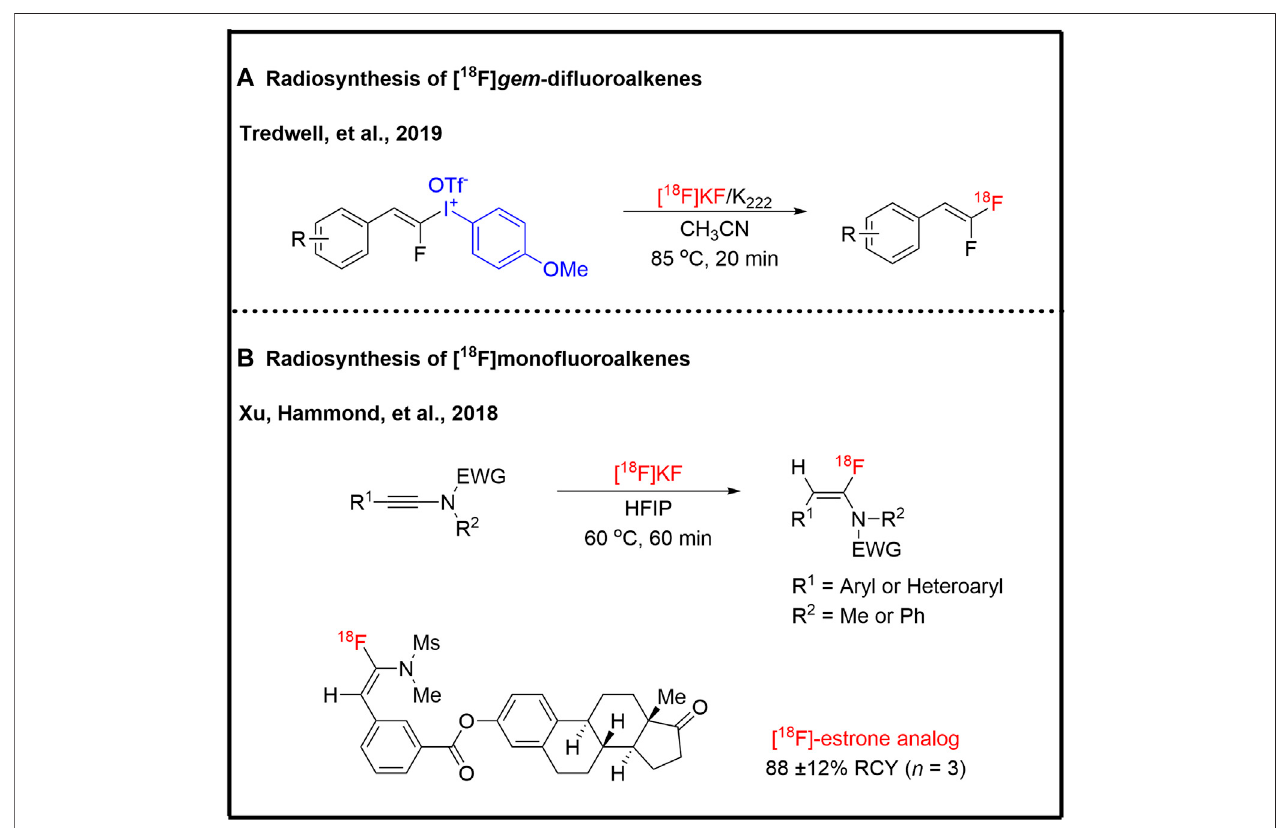
FIGURE 4 | Radiosynthesis of fl